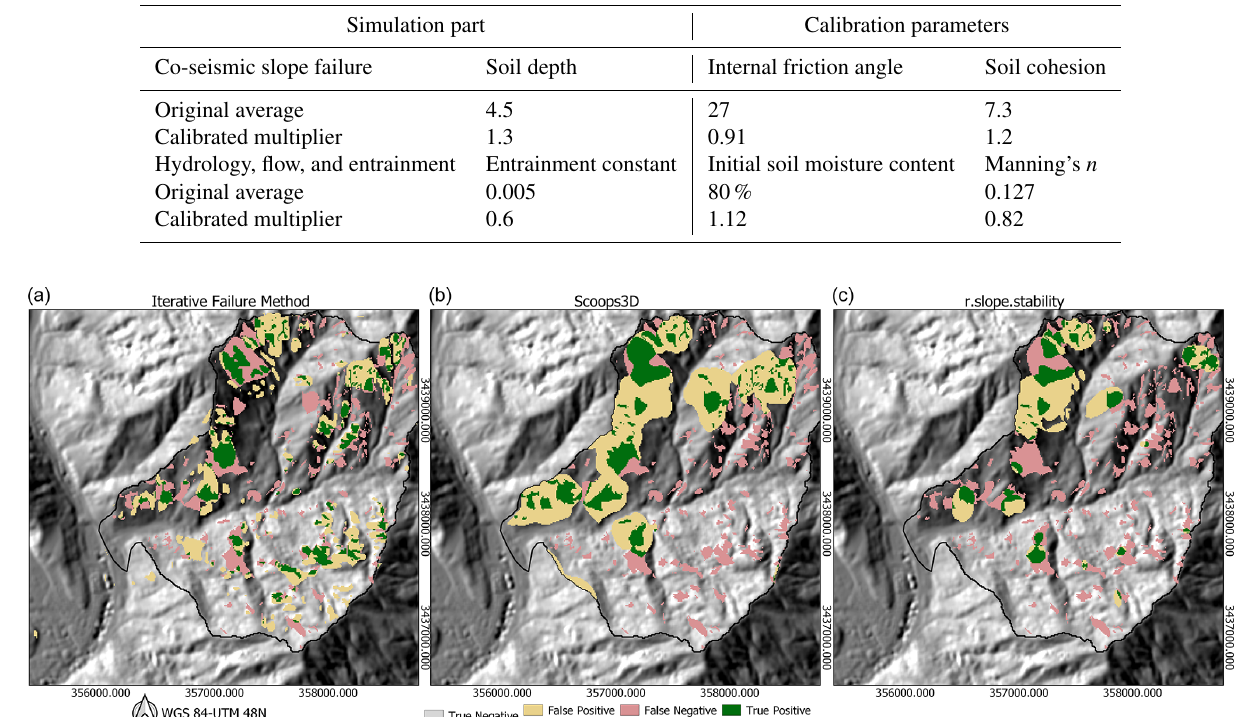
Table 3. Calibration parameters, their initial values, and their final calibrated values for both chains.